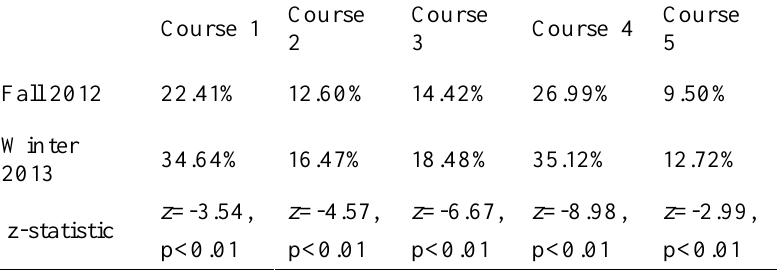
Percentage of Learners in the Target Group Who Have Less than a 4-year Degree by Course Course